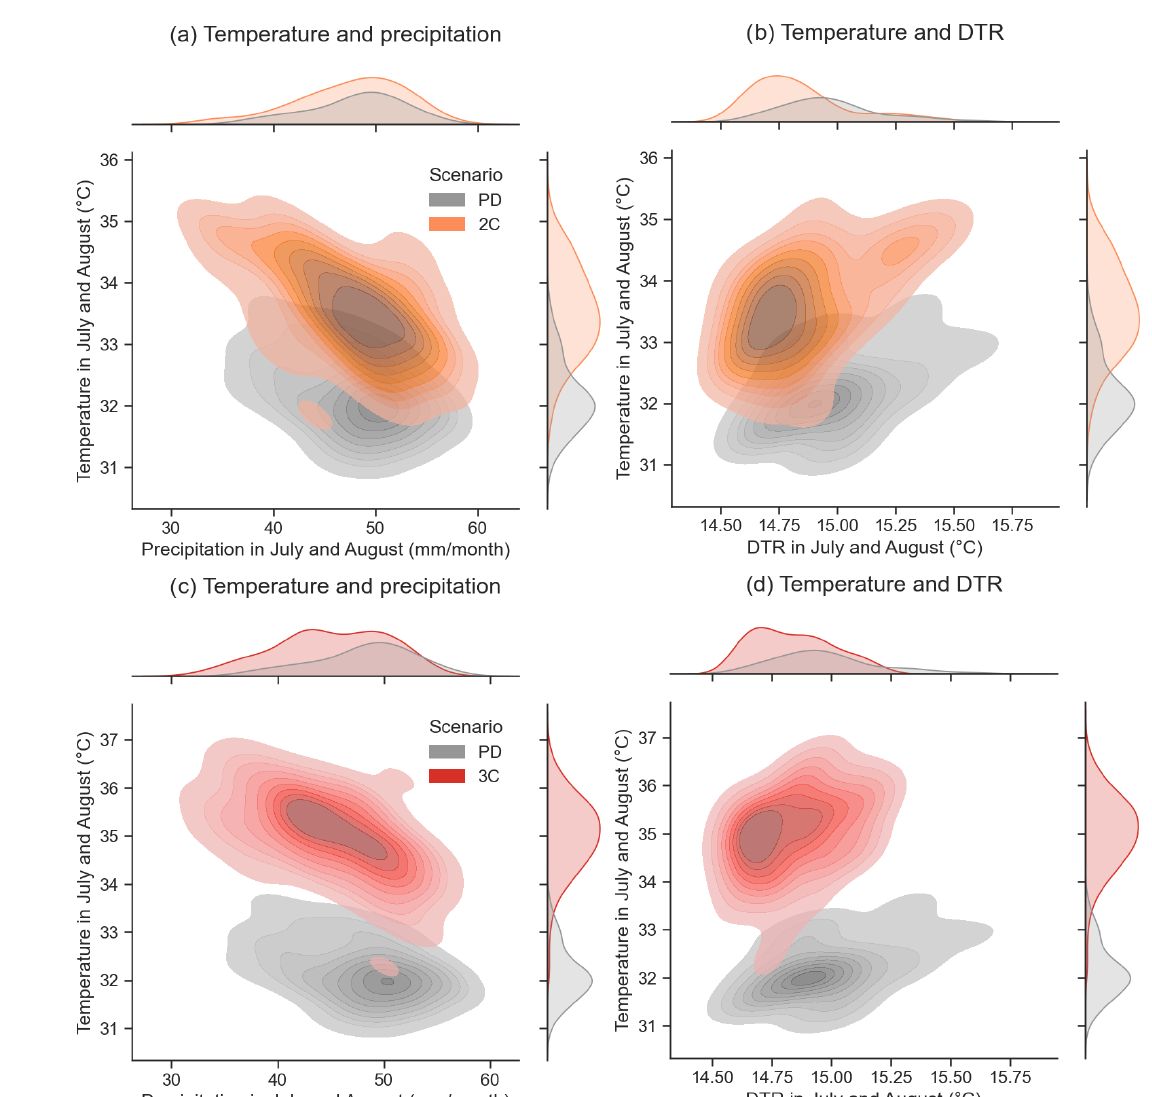
Figure C10. Same as Fig. 7 but for the 2012 impact analogues.